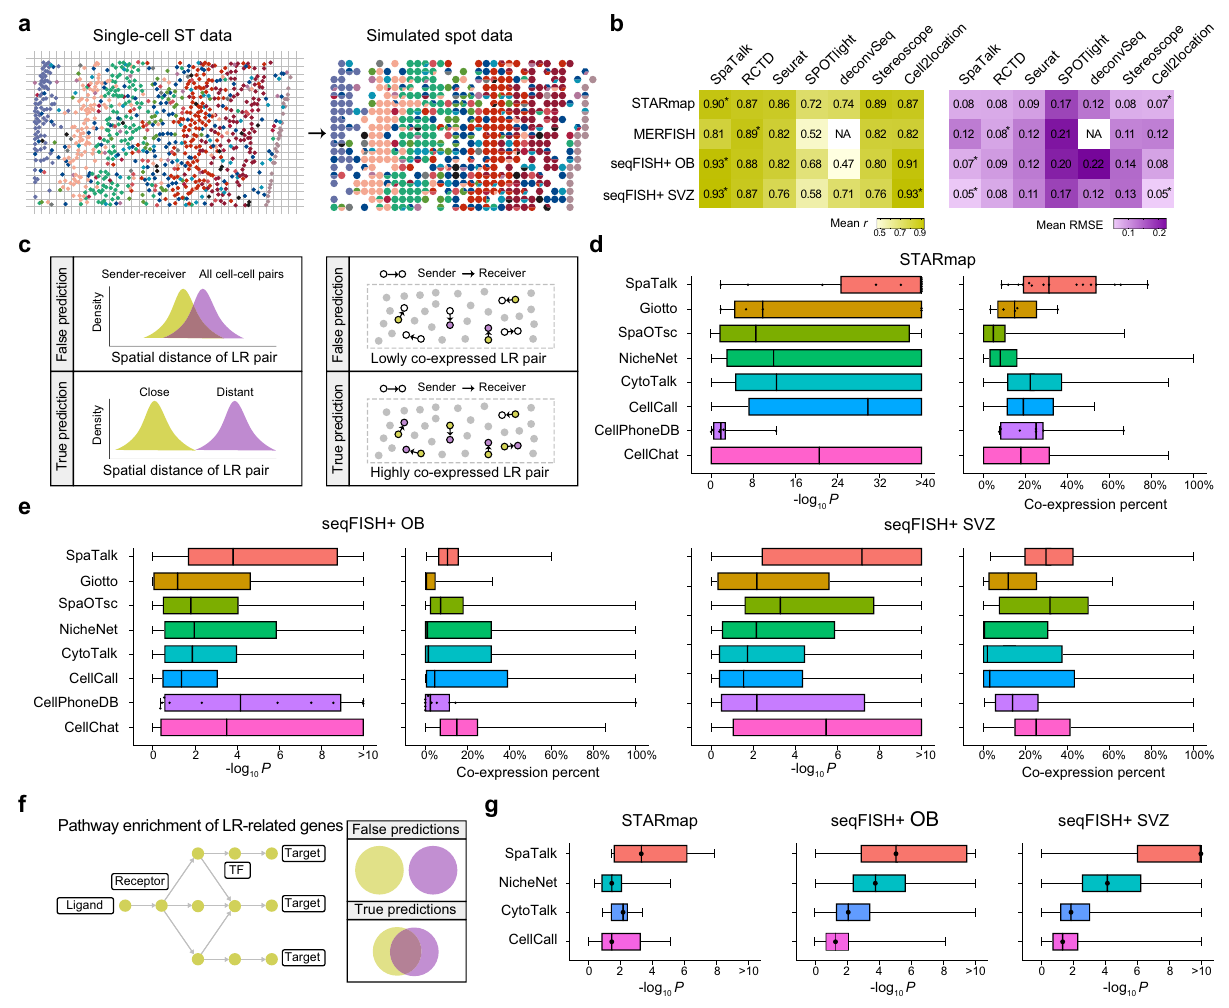
Fig. 2 | Superior performance of SpaTalk over existing methods. a Schematic diagram for generating simulated spot data.Cells were split according to the fi xed spatial distance and then merged for the single-cell ST data with known cell types. b Performance comparison of SpaTalk with other existing cell-type deconvolution methods (RCTD, Seurat, SPOTlight, deconvSeq, Stereoscope, Cell2location). The asterisk represents the top-ranked method for each dataset. NA, not available. c Schematic illustration of the procedure and rationale for single-cell ST data to evaluate predicted LRIs that mediate spatially resolved cell – cell communications. d and e PerformancecomparisonofSpaTalkwithexistingcell – cellcommunication inference methods (Giotto, SpaOTsc, NicheNet, CytoTalk, CellCall, CellPhoneDB, and CellChat) on the STARmap and seqFISH+ datasets. The P -value represents the difference of spatial distances between sender-receiver and all cell – cell pairs assessedwiththeWilcoxontest.Fortheboxplots(minima,25thpercentile,median, 75thpercentile,andmaxima)fromSpaTalktoCellChat,thenumbersofdatapoints for the STARmap dataset are 15, 5, 676, 537, 75, 31, 7, and 166, respectively;